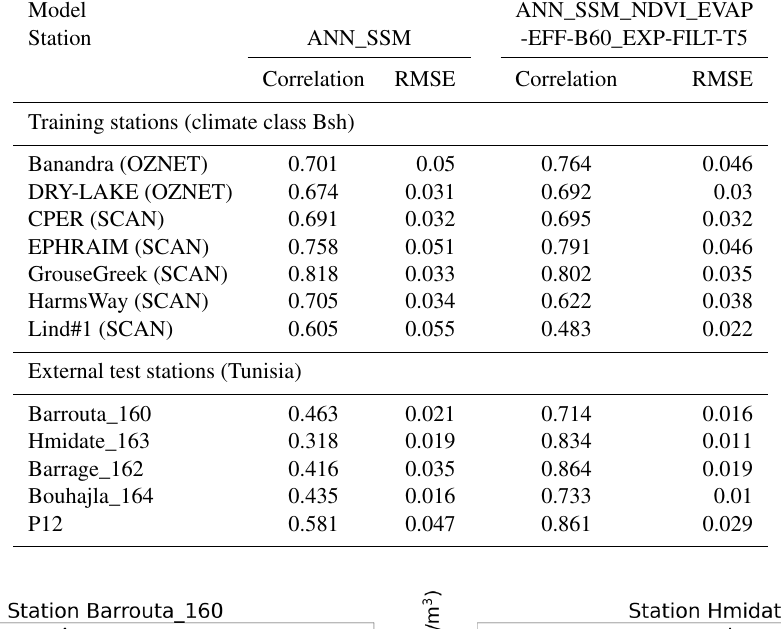
Table 5. Performance metrics of models ANN_SSM and ANN_SSM_NDVI_EVAP-EFF-B60_EXP-FILT-T5 at training stations of climate “Bsk” and Tunisian stations of climate “Bsh”.